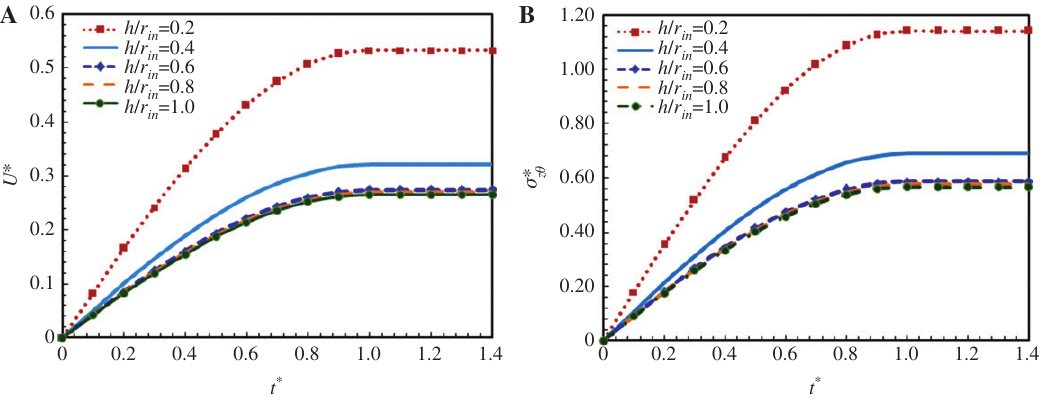
Figure 6 Time response of the FG cylinder with different ratios of thickness-to-inner radius for (A) U * and (B) σ * of the cylinder mid-length and θ = 0 ° with inner radius of 0.08